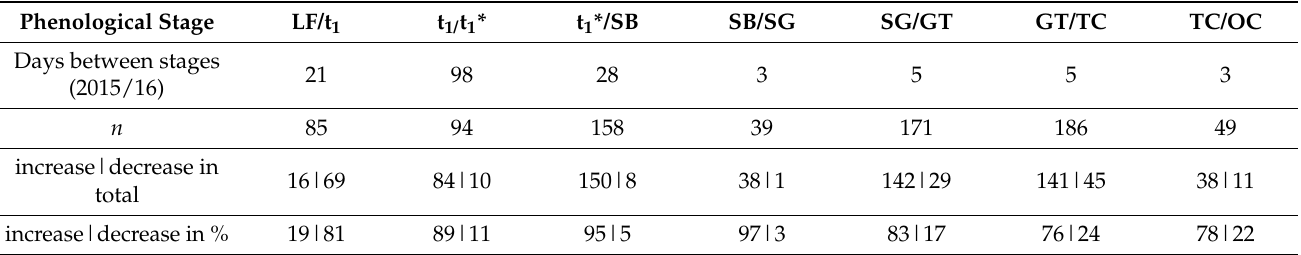
Table 2. Number ( n ) of metabolites in sweet cherry buds, cv. ‘Summit’, which significantly changed between phenological stages in the 2015/16 season (Welch’s two-sample t-Test; p ≤ 0.05). ‘Total leaf fall’ (LF), endodormancy release (t 1 ), beginning of ontogenetic development (t 1 *) ‘swollen bud’ (SB, DOY 89), ‘side green’ (SG, DOY 92), ‘green tip’ (GT, DOY 97), ‘tight cluster’ (TC, DOY 102), ‘open cluster’ (OC). DOY, day of